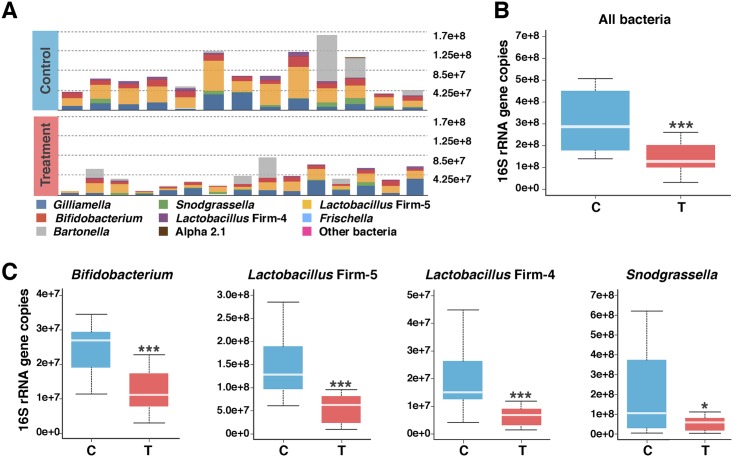
Changes in the honeybee gut microbiota after 5 d of tetracycline treatment (Day 0 post-treatment).A) Stacked column graph showing the abundance of bee gut bacterial species in control bees (n = 14) and treatment bees (n = 15). Abundance of the bee gut bacterial species was estimated by correcting for absolute abundance (estimated by qPCR) and taking into account rRNA operon number per genome (S1 Table). B) Boxplot of total bacterial 16S rRNA gene copies estimated by qPCR for control and treatment bees. C) Boxplots showing decreased abundance of four core gut species in treatment bees (estimated by multiplying the percent relative abundance of each species by the total bacterial 16S rRNA gene copies and correcting for rRNA operon number per genome). Box-and-whisker plots show high, low, and median values, with lower and upper edges of each box denoting first and third quartiles, respectively. * = p < 0.05 and *** = p < 0.0001, Wilcoxon rank sum tests. See S1 Data for absolute and relative abundance data.